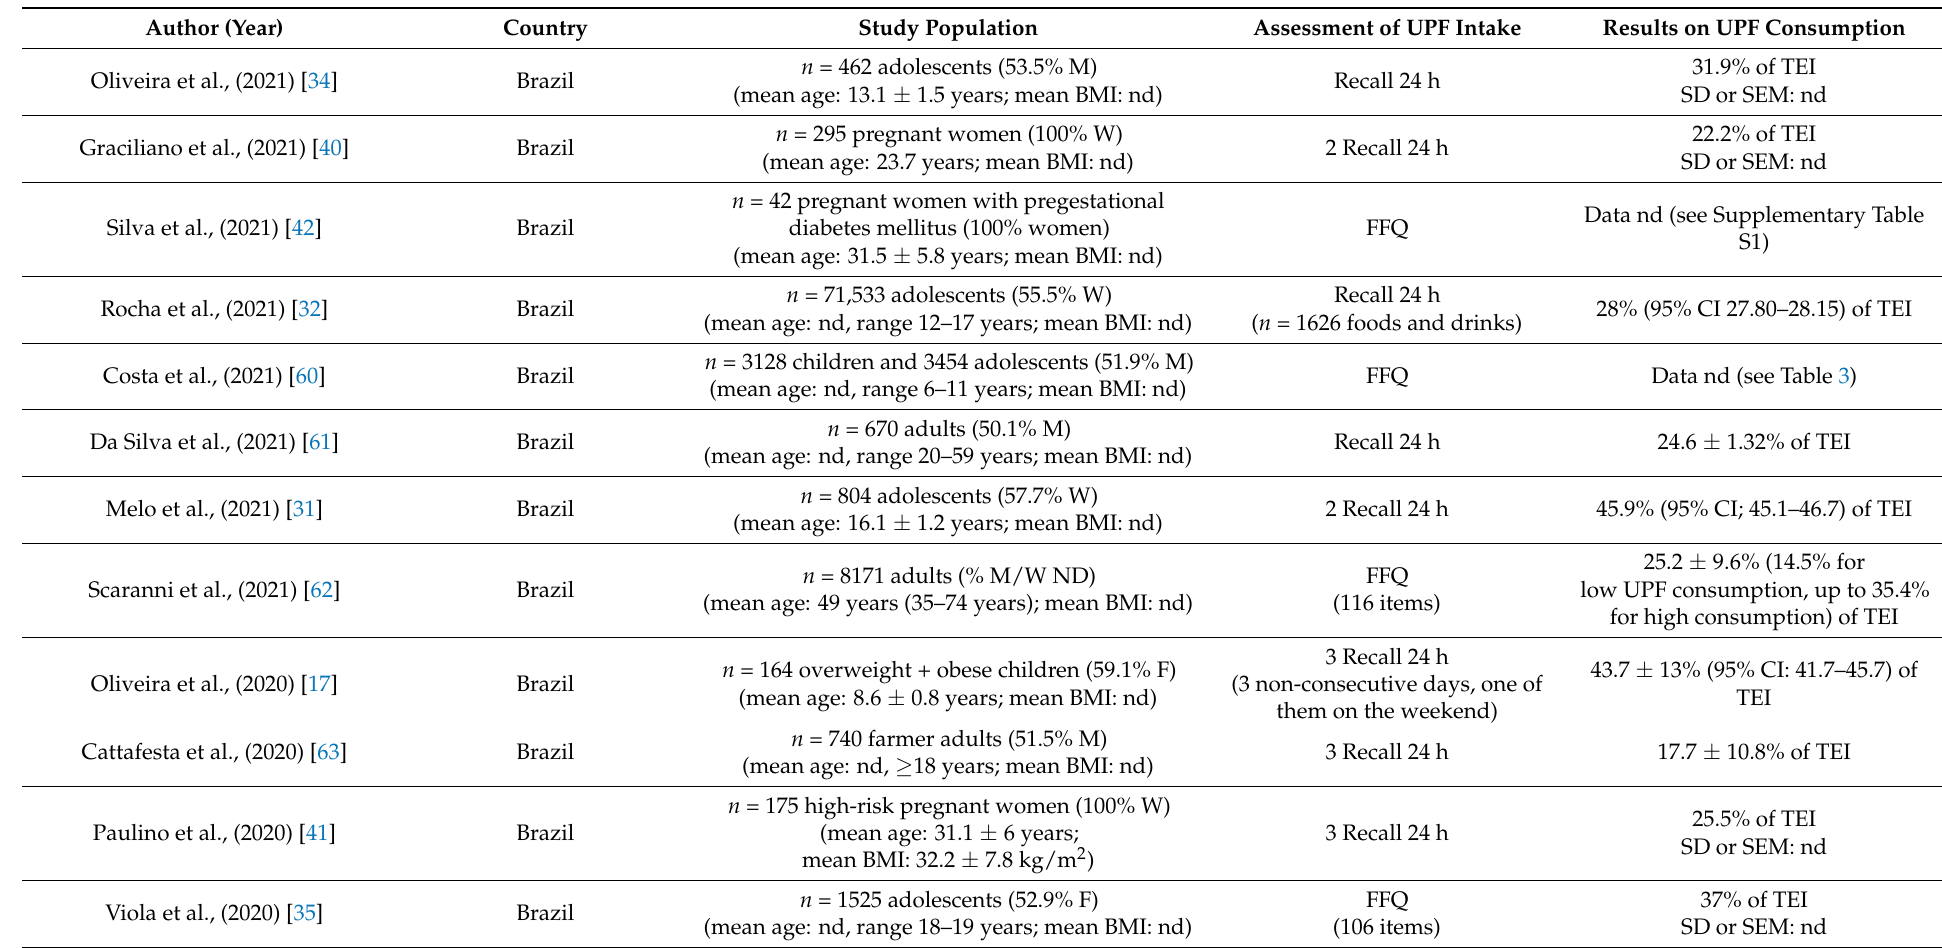
Table 1. Characteristics of the selected studies ( n = 106) and the level of consumption of ultra-processed foods (UPF) expressed as the percent of energy provided by UPF intake with respect to total energy intake